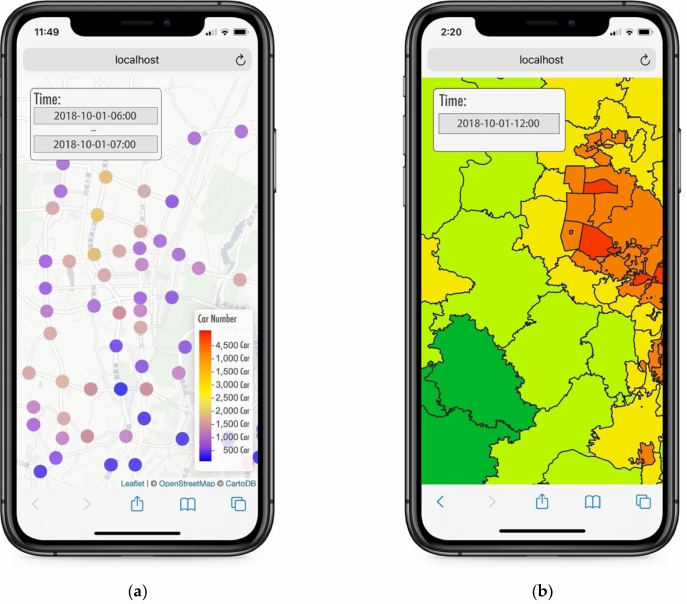
Figure 12. The interfaces for visualization maps. ( a ) Interface for the road vehicle density visualiza- tion map. ( b ) Interface for the regional vehicle density visualization